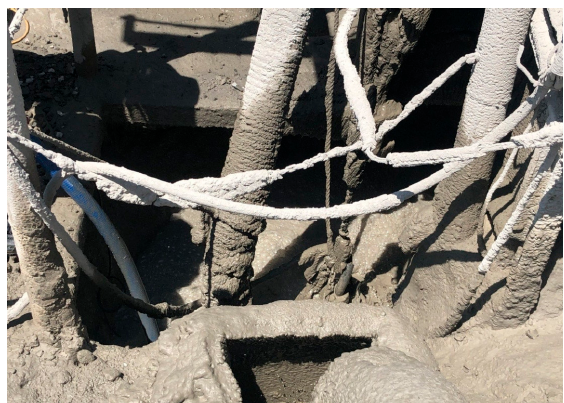
Table 3. Chemical composition of the concrete slurry waste (obtained by XRF spectroscopy).